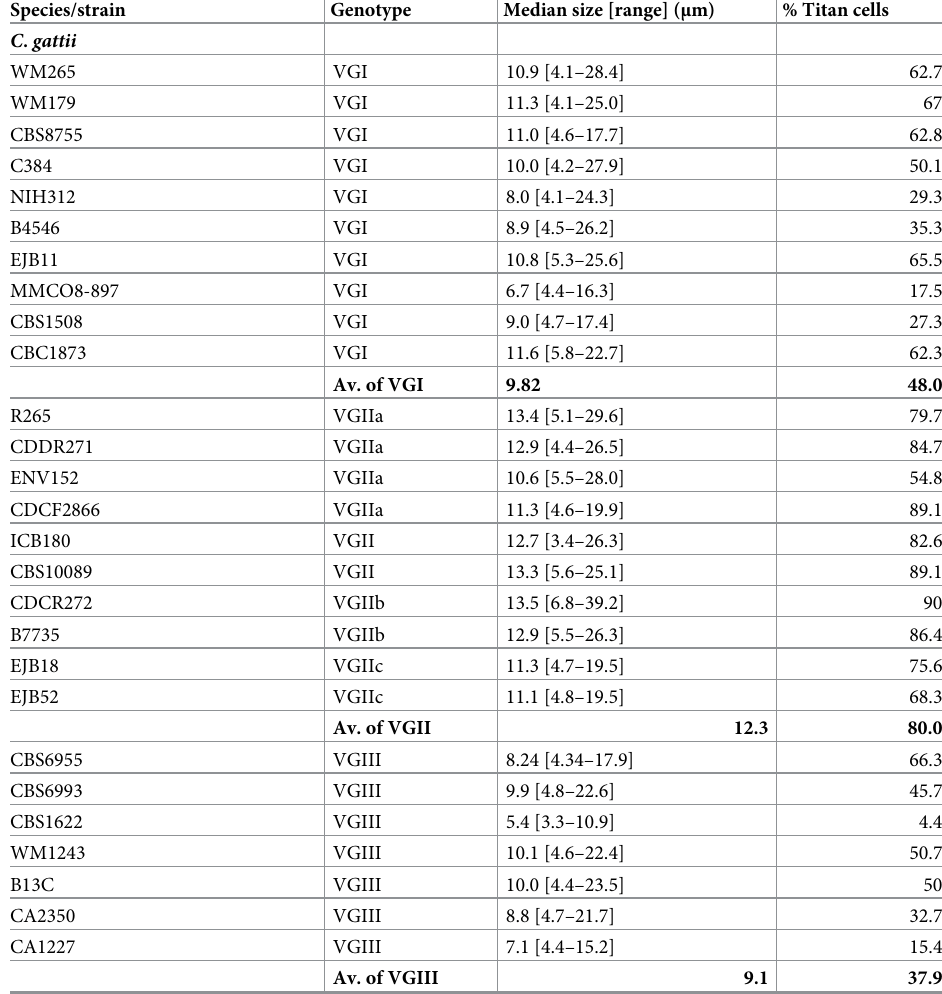
Table 1. Capacity to form titan cells across cryptococcal isolates. Percentage of titan cells was determined based on capacity to enlarge > 10 μ m (S4 Fig) and having > 2C ploidy (S5 Fig).